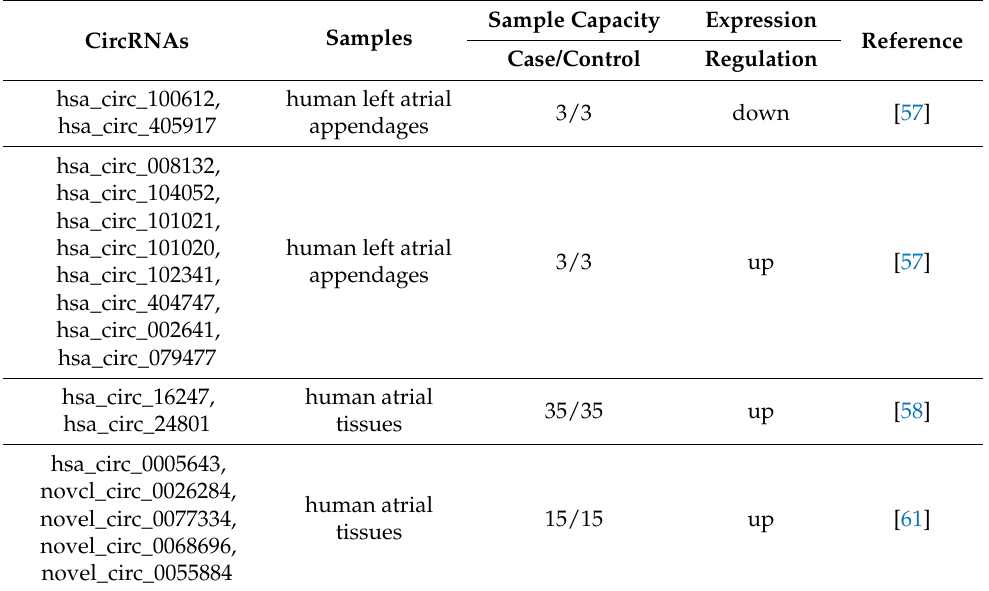
Table 5. Different expressions of circRNAs in atrial fibrillation validated by real-time